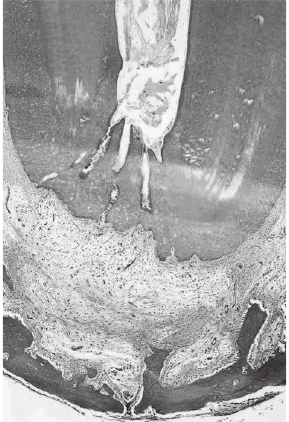
Figure 6. Group II (collagen/hydroxyapatite). Root apex with areas of cemen- tum resorption. Moderately increased periodontal ligament thickness, with the presence of moderate inflammatory cells infiltrate. HE; magnification X24.